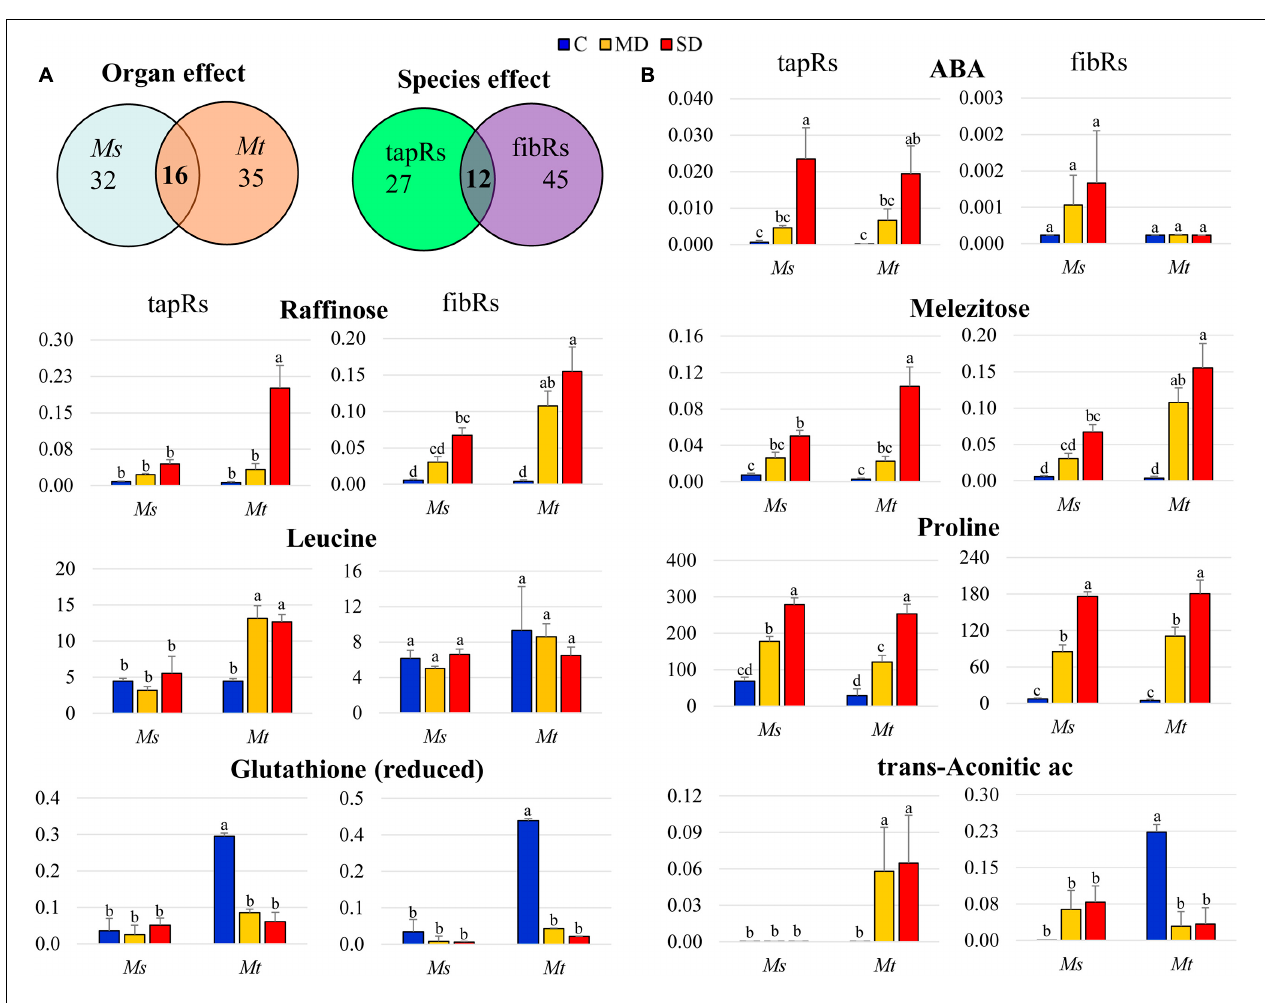
FIGURE 5 | Detailed analysis of metabolites showing tissue- or stress-dependent responses. (A) Venn diagrams representing metabolites showing interaction between organs (left) and/or species (right) and the water deficit treatment (two-way ANOVA). (B) Relative intensity values of metabolites showing organ and/or species-dependent interactions with the water deficit treatment. Bars represent means ± SEs ( n = 5 biological replicates). Different letters indicate significant differences according to a Duncan-test ( P ≤ 0.05). Ac, acid; fibRs, fibrous roots; tapRs, taproots; Ms , Medicago sativa ; Mt , M. truncatula